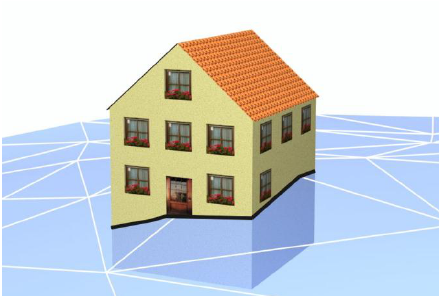
Figure 1. TerrainIntersectionCurves in CityGML (Gr¨oger et al.,